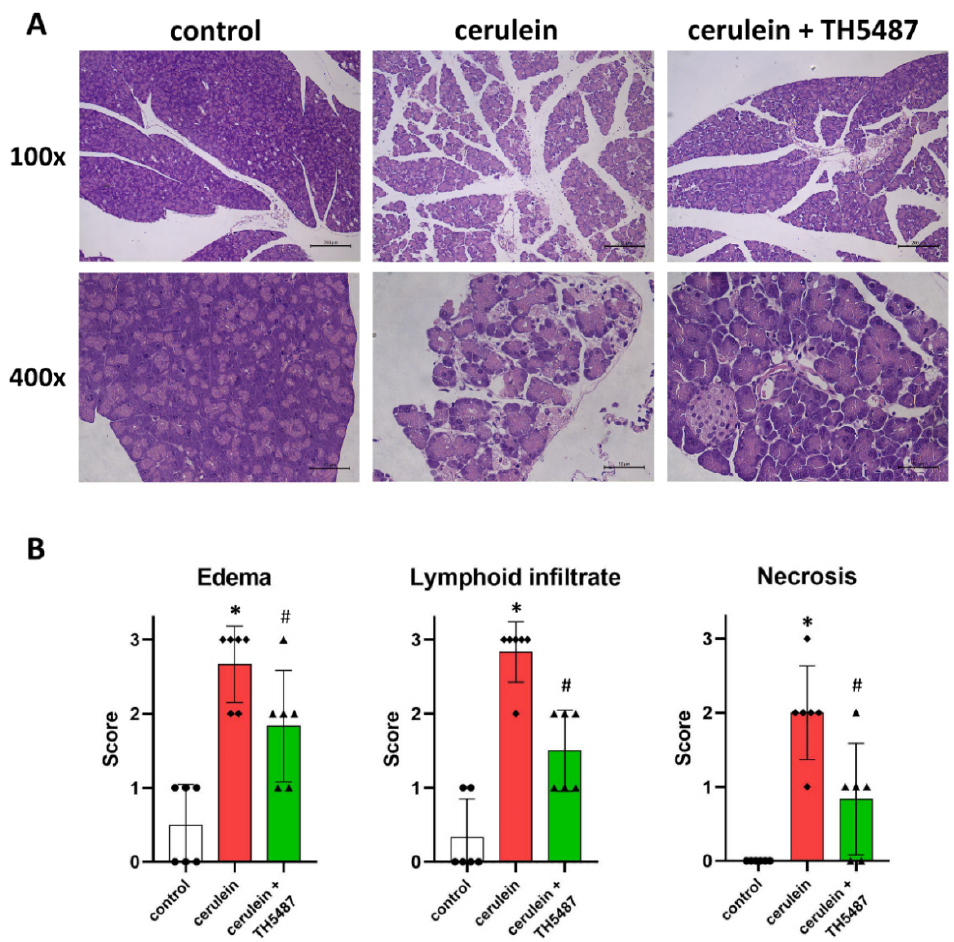
Figure 2. The OGG1 inhibitor TH5487 reduces inflammation and tissue injury of the pancreas. Representative images of H&E-stained pancreatic sections are presented ( A ). Tissue damage of the pancreas was observed histologically in the cerulein-treated group. TH5487 significantly reduced edema, inflammatory cell infiltration and tissue necrosis (cerulein + TH5487). The morphological changes in the pancreata were evaluated by an experienced pathologist ( B ). Magnifications were 100× and 400×. Scale bars represent 200 and 50 μ m. Values are presented as mean ± SD, n = 6. * p < 0.05 vs. control group, # p < 0.05 vs. cerulein group .